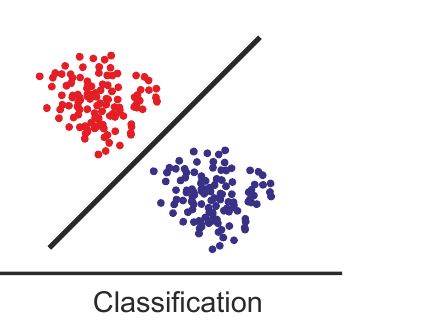
Figure 4. Classification and regression approaches to BCI control of two-targets (adapted from [210]). The regression algorithms employ the features extracted from EEG signals as independent variables to predict user intentions. In contrast, the classification approach uses the features extracted as independent variables to define boundaries between the different targets in feature